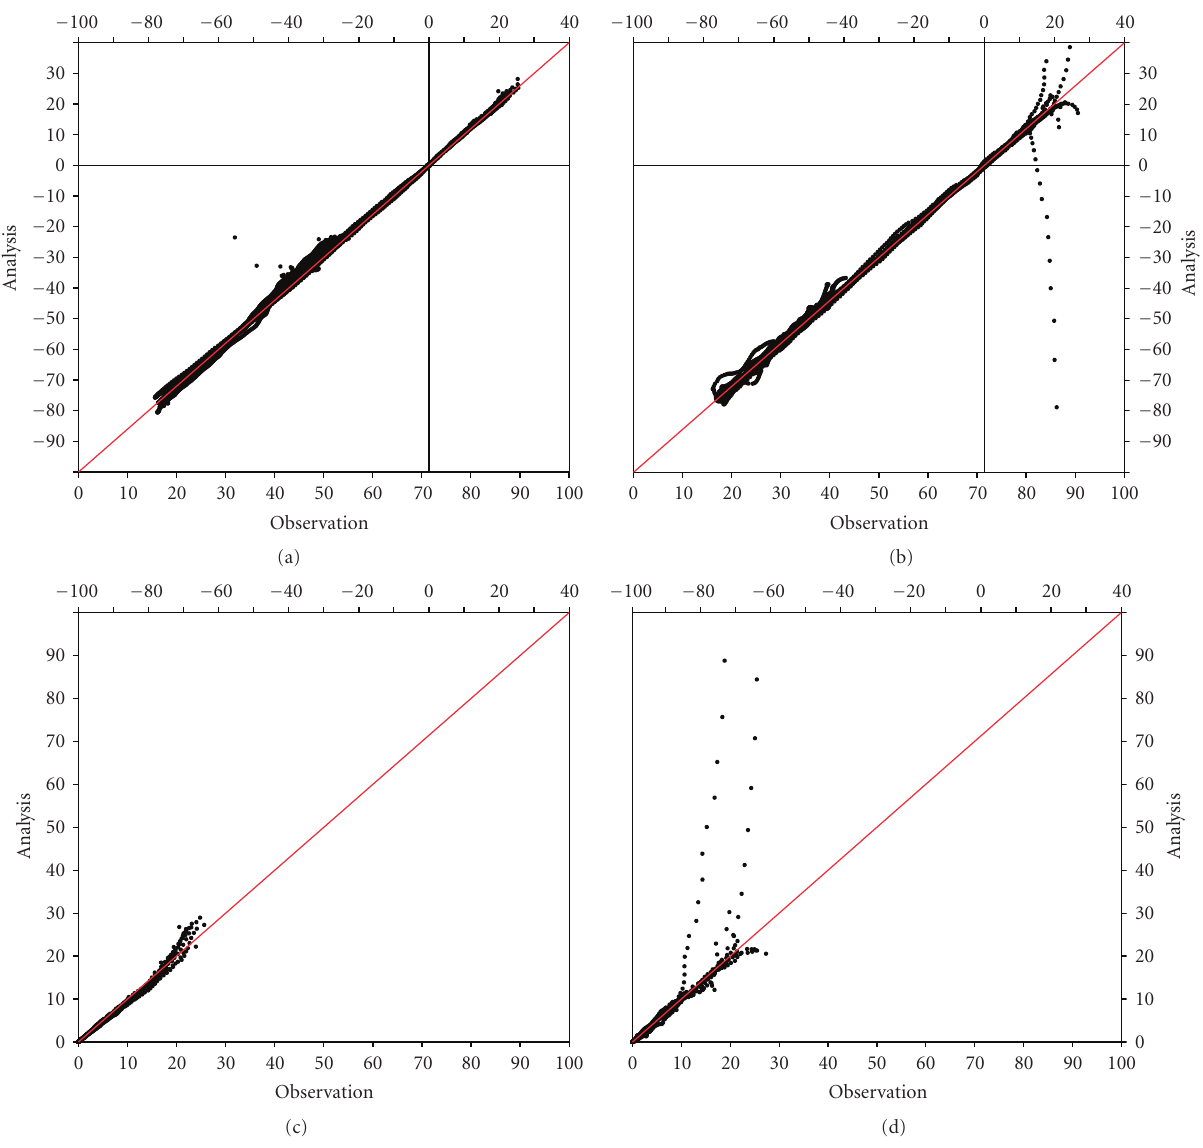
Figure 6: Scatter-plot of observations ( x -axis) versus colocated global analysis profiles and/or radiosonde observations ( y -axis). Red line represents best-fit line. (a) Radial mean temperature ( ◦ C) observations versus radial mean colocated global analysis temperature ( ◦ C) profiles. (b) Radial mean temperature ( ◦ C) observations versus radial mean colocated radiosonde observation temperature ( ◦ C) profiles. (c) Radial mean water vapor pressure (hPa) observations versus radial mean colocated global analysis water vapor pressure profiles, from the surface to 10-km. (d) Radial mean water vapor pressure (hPa) observations versus radial mean colocated radiosonde observation water vapor pressure profiles